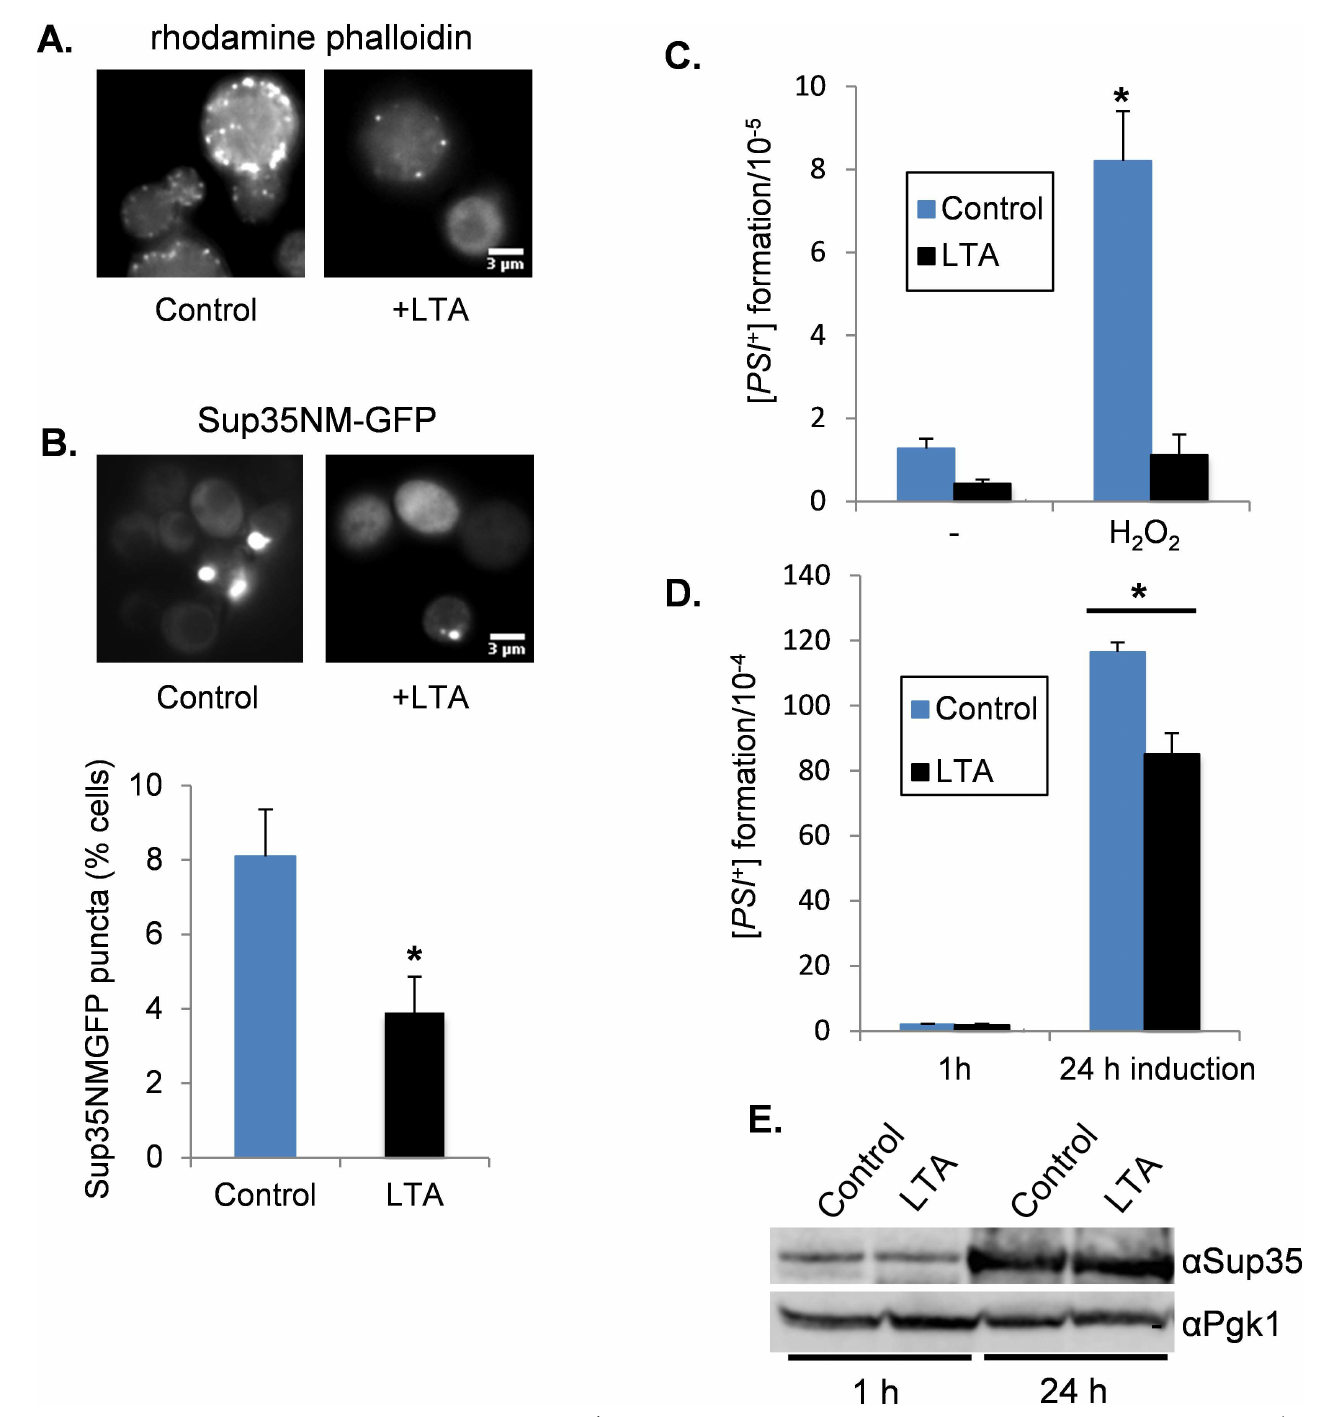
Fig 4. Latrunculin A treatment reduces oxidant-induced [ PSI + ] formation. A. Representative fluorescence micrographs are shown for a [ PIN + ] [ psi - ] strain treated with 10 μ M LTA for 20 hours. Cells were fixed, and stainedwith rhodamine phalloidinto visualizethe cortical actin cytoskeleton. B. Fluorescence micrographsare shown for a [ PIN + ][ psi - ] strain treated with 100 μ M hydrogen peroxidefor 20 hours in the presence or absenceof 10 μ M LTA. The aggregatefrequency is shown as the percentageof cells containing visible Sup35foci from approximately 1000 cells counted. Error bars denote standarddeviation; * marks statistical significanceat p < 0.01. C. [ PSI + ] prion formation was quantifiedin a [ PIN + ][ psi - ] strain treated with 100 μ Mhydrogen peroxidefor 20 hours in the presenceor absenceof 10 μ M LTA. Data shown are the means of three independentbiological repeats expressedas the number of [ PSI + ] coloniesper 10 5 viable cells. Error bars denotestandard deviation; * marks statistical significance at p < 0.01. (D) [ PSI + ] prion formation was quantifiedin a [ PIN + ][ psi - ] strain containing the Sup35NM-GFP plasmidfollowing1 and 24 h of copper